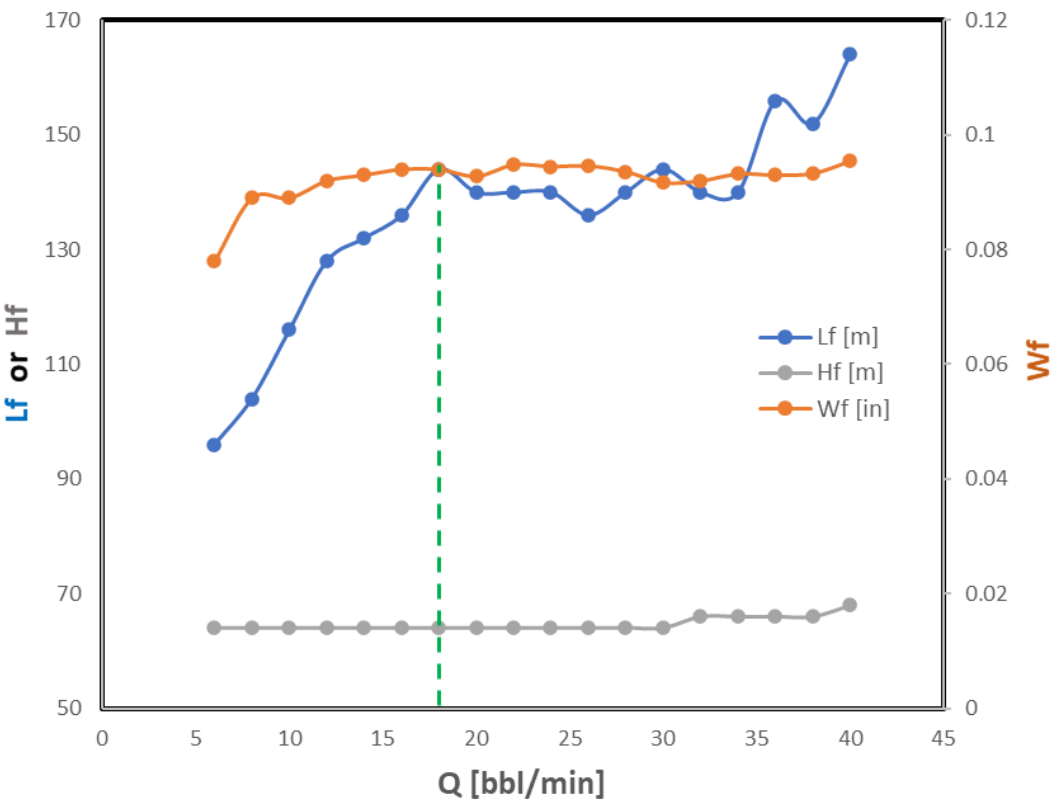
Figure 8. Injection flow rates optimization with three stages of acid batch and with total fluid volume of 90 K-gal.